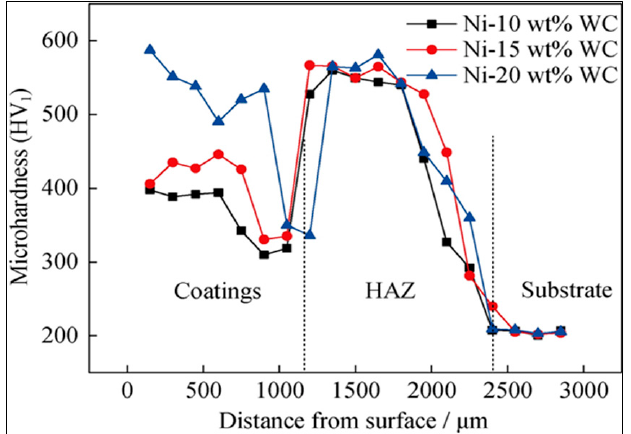
Figure 26. Microhardness distribution of laser cladding layers with different WC content (adapted with permission from Ref. [72] 2021, Springer).